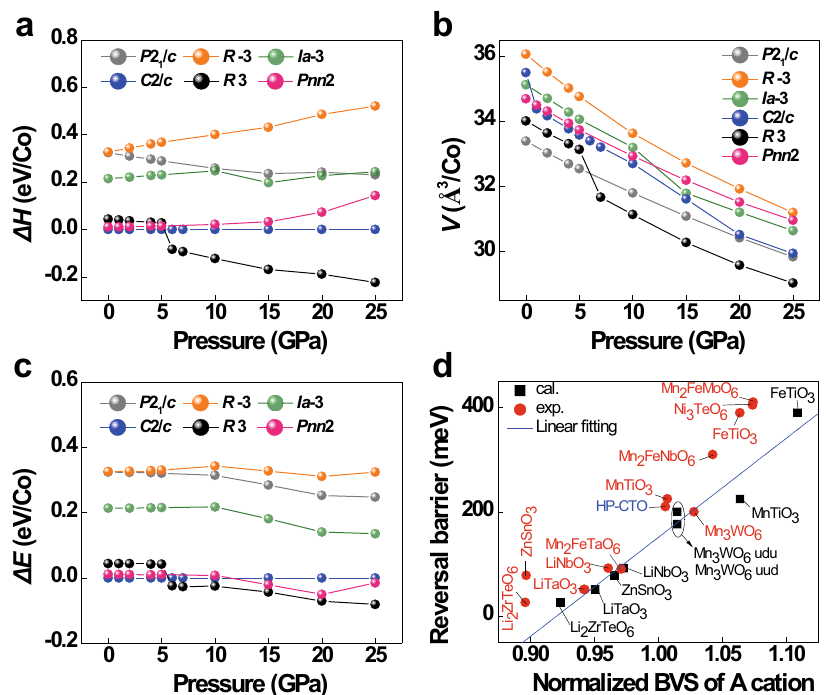
Fig. 2 Theoretical calculation results on CTO. Calculated pressure dependencies of the a relative enthalpies, b volume, and c relative total energy of CTO in the six possible polymorphs. The Y -axis demonstrates the relative enthalpies, volume, and relative total energy divided by the number of Co in a unit cell for better comparison. d Scatterplot of domain-wall-mediated reversal barrier versus normalized BVS (divided by the valence charge) of the A -cations, where the black squares denote the normalized BVS calculated (cal.) from the optimized crystal structure, while the red spheres are for the normalized BVS from the experimental (exp.) CIFs (crystallographic information fi les). The “ u ” and “ up ” and “ down ” spin arrangement from ref. 36 , “ d ” in Mn 3 WO 6 represent for the such as piezoelectric, ferroelectric, and magnetoelectric behaviors. constant moment spiral magnetic structure consisting of AFM helixes propagating along the с axis (the helixes are associated Figure 5a present the topography and piezoresponse force with the Co1, Co2, and Co3 atomic chains; Fig. 4b). At 5 K, the microscopy (PFM) phase and amplitude images for the polished magnetic moments of the Co1 chain is rotated about ≈ 53.0° with polycrystalline HP-CTO at room temperature, where different respect to that of Co2 and about ≈ 85.6° with respect to Co3 (Fig. polarization states correspond to the bright and dark contrasts in 4c, left). However, at T = 45 K the rotation angles are different: the phase and amplitude images (Fig. 5a middle and right), which ≈ 21.0° between the Co1 and Co2 moments and ≈ 143.0° between are independent from the topography (Fig. 5a, left). The the Co1 and Co3 moments. (Fig. 4c, right). The magnetic moment observation of ferroelectric domain inside a hexagonal grain of each subsequent atom along the chain rotates relative to the indicates the electromechanical coupling of HP-CTO at room previous one by ≈ 170.3° and 74.8° at T = 5 and 45 K, respectively. temperature, originating from the non-centrosymmetric structure of this new material. Temperature dependence of the dielectric constant ε ′ of HP-CTO at various magnetic fi elds is shown in Fig. 5b, inset of which shows the temperature-dependent dielectric constant at frequencies from 10 Hz to 100 kHz. A peak in the dielectric constant appears at ~58 K, which coincides with the magnetic transition temperature ( T 2 ~ 58 K). The position of this peak does not change with increasing frequency, indicating the intrinsic nature of the dielectric anomaly. As shown in Fig. 5b, in magnetic fi elds <1 T, the dielectric peak at ~58 K remains intact with a slight downshift to low temperatures. However, above 1 T, the peak at ~58 K becomes broad and gradually inconspicuous with further increase of the magnetic fi eld. On the other hand, above 1 T, another dielectric peak appears at about 24 K. This peak is also magnetic fi eld dependent and shifts to lower temperatures with increasing magnetic fi eld. The temperature of this second dielectric anomaly coincides with the magnetic transition temperature T 1 ~ 24 K. The above results indicate that the two different magnetic states observed in the magnetic properties are re fl ected in the dielectric constant by two distinct dielectric anomalies. Magnetic order also induces changes in the electrical polariza- tion and the magnetic order induced polarization is magnetic fi eld